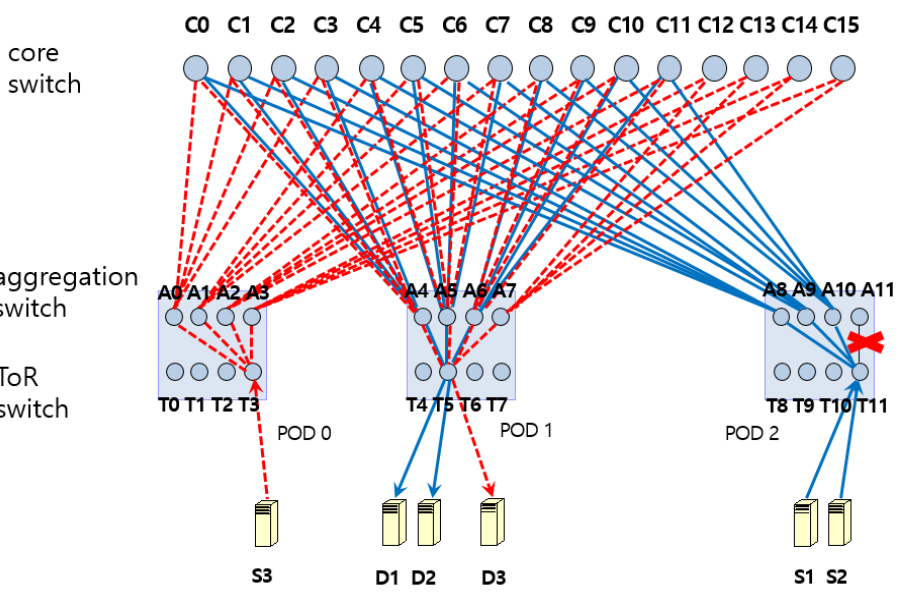
Figure 1. Illustration of a packet scatter scheme in an 8-ary fat-tree.